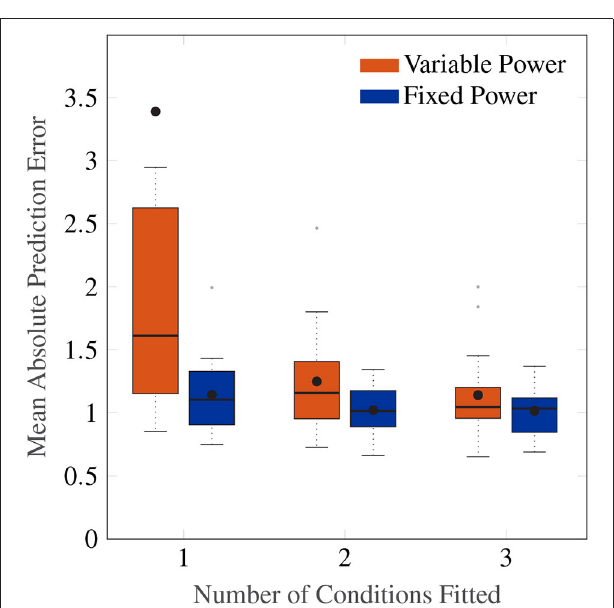
FIGURE 8 | Box plot showing the mean absolute prediction errors for when 1, 2 and 3 cases are fitted to predict 3, 2 and 1 other conditions, respectively. The orange Box plots show prediction errors for the individual-level power law, and the blue Box plots show the prediction errors for the power law fixed to